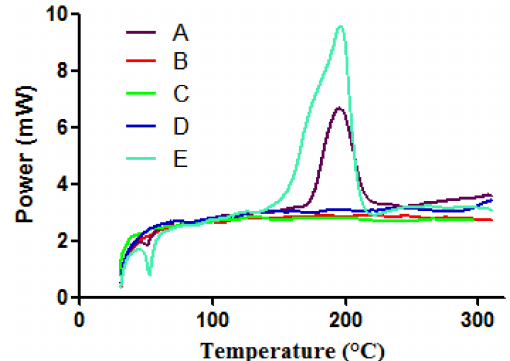
FIGURE 2 - FTIR spectra of gelatin (A), gelatin/chitosan (B) and chitosan (C) films.